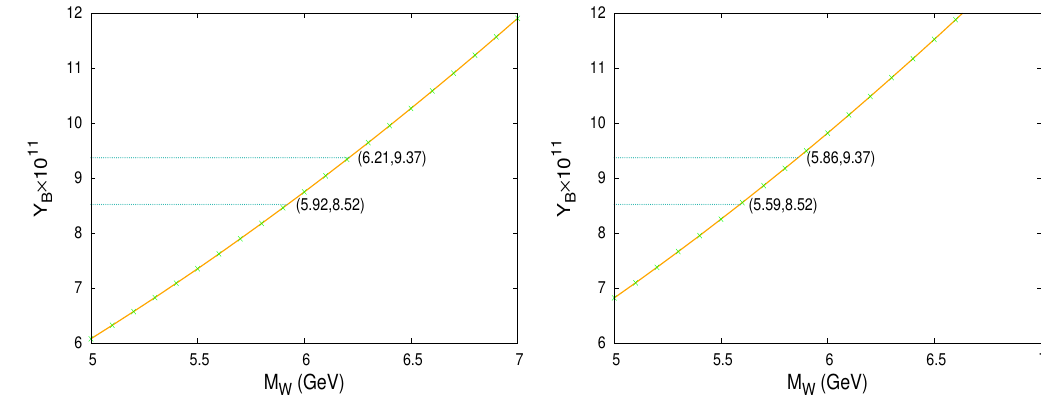
Figure 7 . The variation of (cid:12)nal Y B with M w (other Lagrangian parameters (cid:12)xed at best (cid:12)t) and determination of bound on M w using the baryon asymmetry bound. Left panel: Y B is evaluated by direct solution of Boltzmann equations, Right panel: Y B is calculated using (cid:20) f